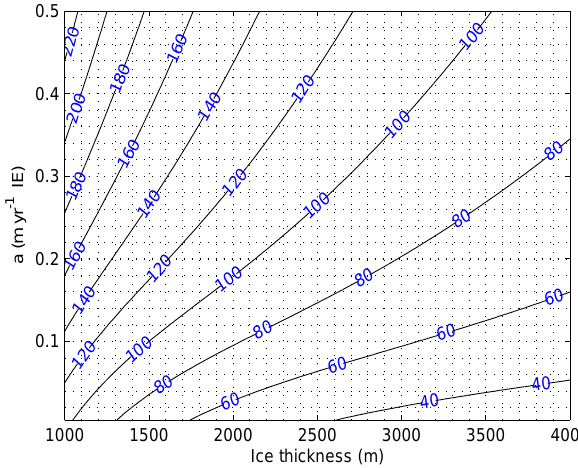
Fig. 2. Minimum GHF (mWm − 2 ) needed to keep the bed at the pressure-melting point as a function of surface accumulation rate GHF (mW m -2 ) needed to keep the bed at pressure-melting point as a func- Fig. 2. Minimum (ice equivalent, IE) and ice thickness and in the absence of horizon- tion of surface accumulation rate (ice equivalent, IE) and ice thickness and in the absence of tal advection. Results are shown for a mean surface temperature of horizontal advection. Results are shown for a mean surface temperature of T s = -50 ◦ C. T s = − 50 ◦